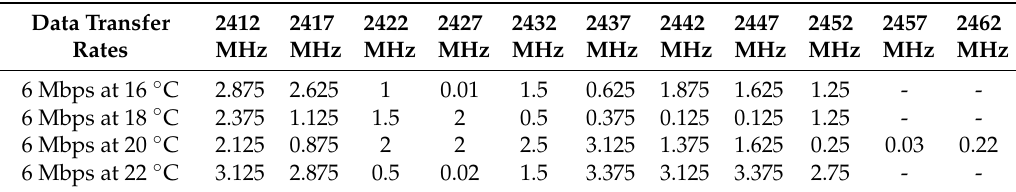
Table 11. Calculation of residuals for OFDM at 6 Mbps.